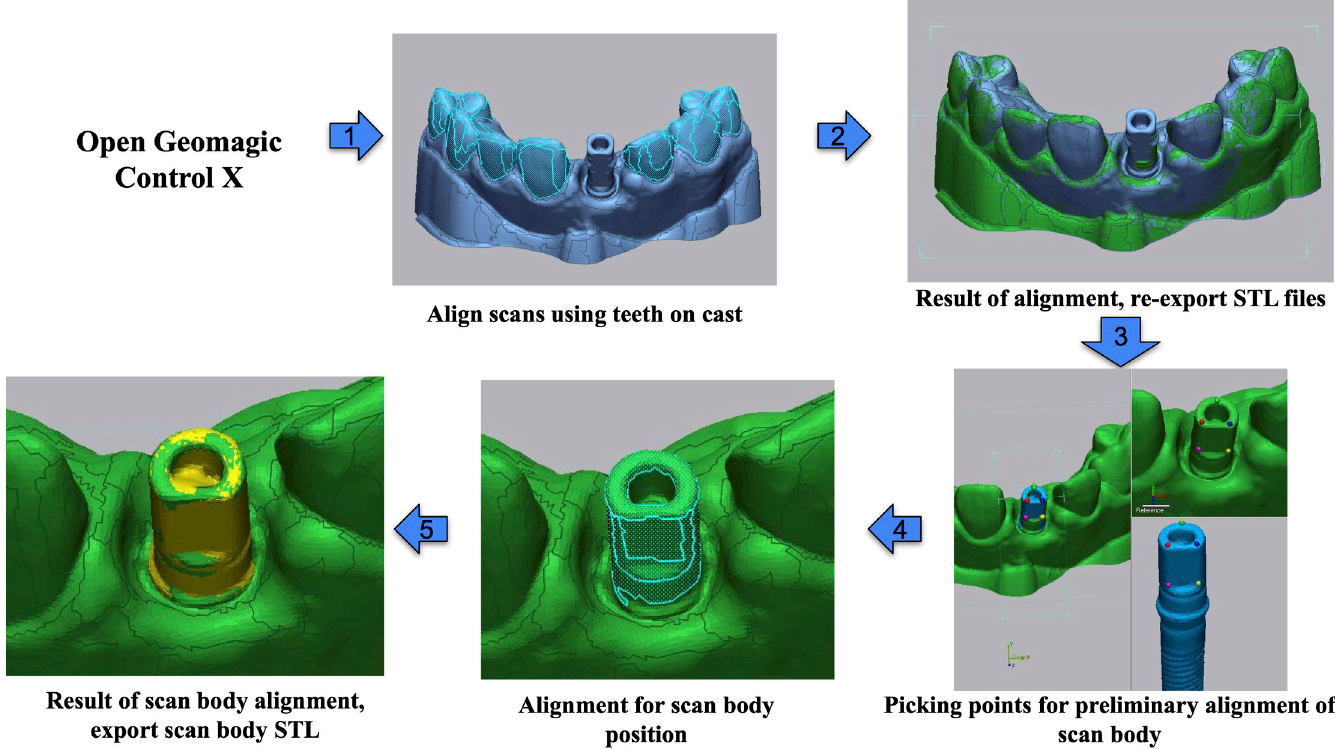
Fig 4. Superimposition of the casts and the scan bodies. Once the scans of the cast were aligned using the remaining teeth, the flat part of the scan body with four reference points and the flat side of the top of the scan body were then used to define the positioning of the screw access. The central axis of the screw access was then used to compare the linear and angular